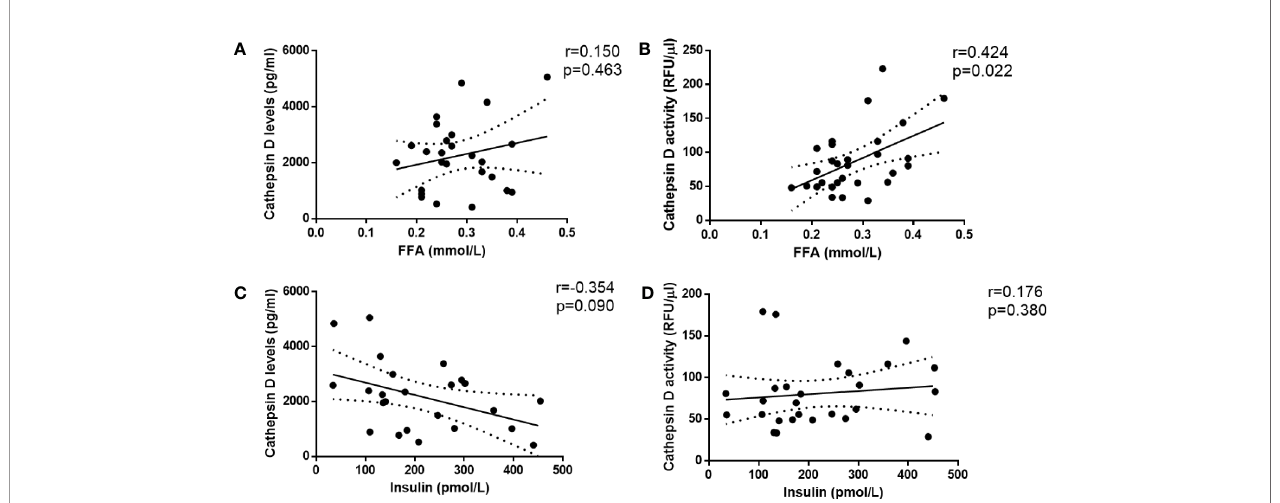
FIGURE 4 | Plasma CTSD activity rather than levels signi fi cantly correlates with metabolic parameter of type 2 diabetes (FFA) in male individuals. CTSD levels (A, C) or activity (B, D) vs. FFA and insulin, respectively. Spearman ’ s correlations were performed. p < 0.05 is considered statistically signi fi